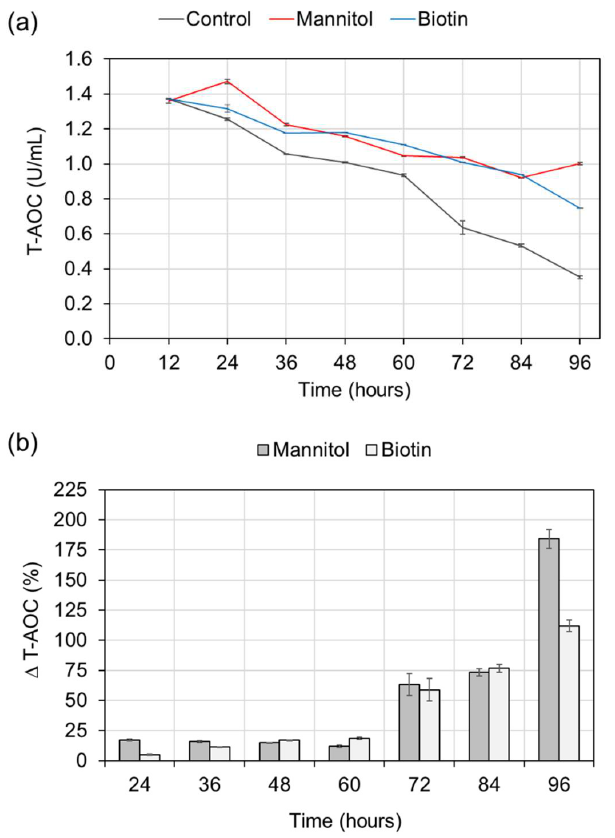
Figure 5. ( a ) Time course profiles of T-AOC in control and supplemented ATCC 26185 cultures, and ( b ) Percentage ∆ T-AOC level of supplemented cultures. The culture was supplemented with 1 g/L mannitol or 0.15 mg/L biotin at 0 h of fermentation. The data are expressed as mean ± SD of triplicate